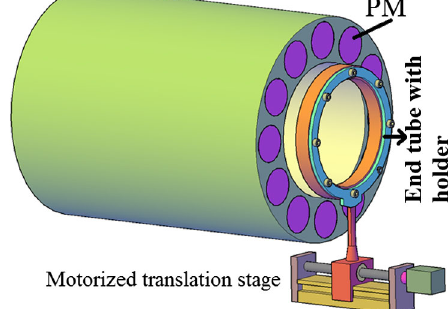
FIG. 10. A schematic diagram of the magnet assembly along with the movement mechanism of the end tube.